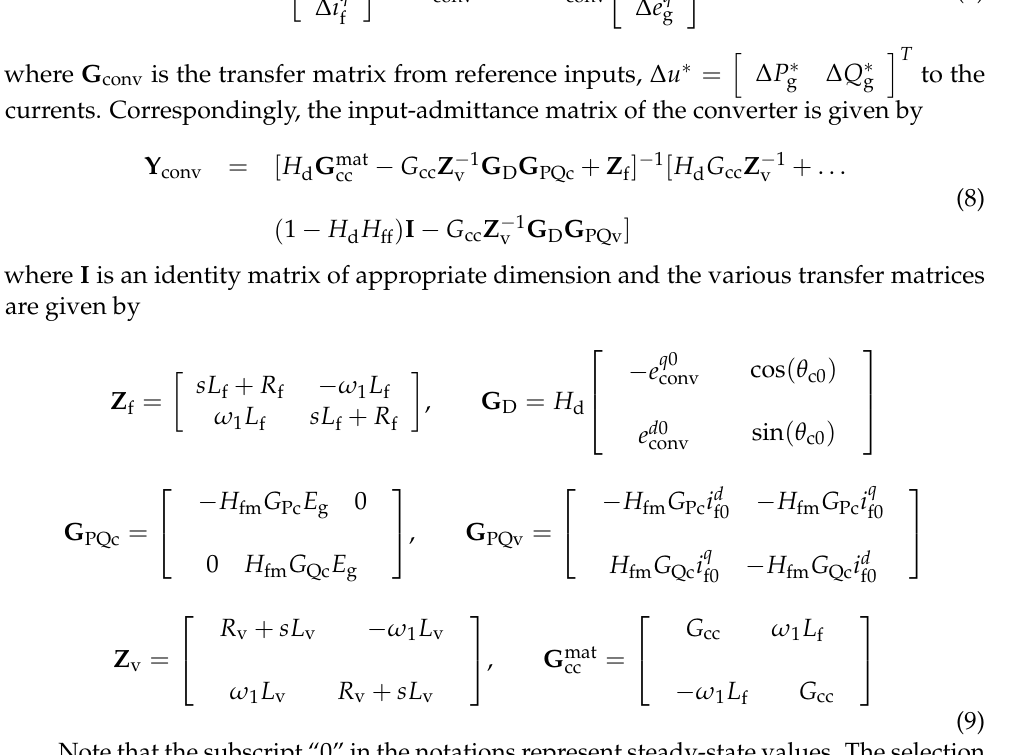
/ S base . For this, the closed-loop base